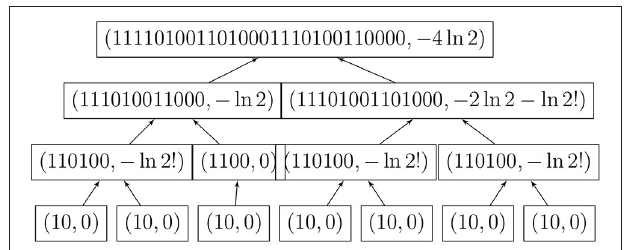
FIGURE 4 | Computing ( c , S ), code and entropy of a rooted tree,